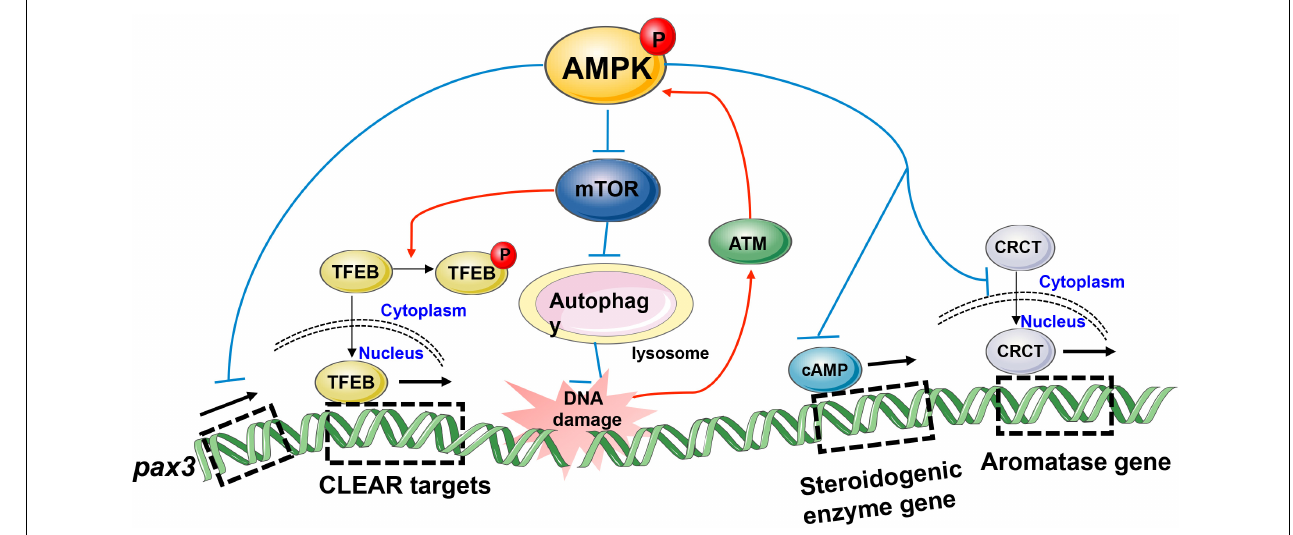
FIGURE 4 | Model depicting transcriptional regulation by phospho-AMPK in the field of reproduction. AMPK activation impacts gene expression involved in biological processes such as embryonic development, spermatocyte DNA damage repair, and gonadal steroid hormones